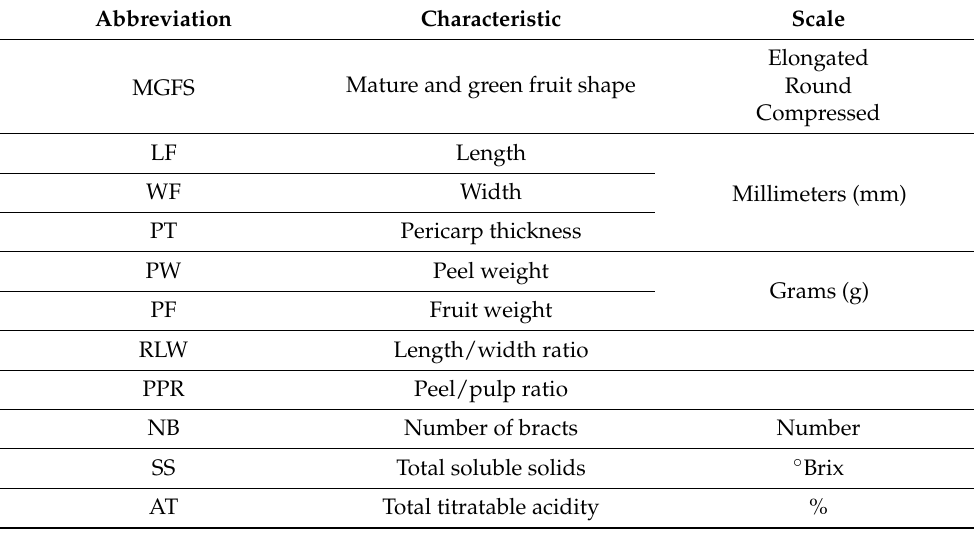
Table 3. Descriptors used in the morphoagronomic characterization of